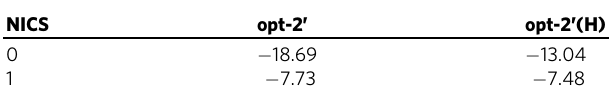
Table 3 Calculated NICS values (at point a , in ppm) of opt-2 ’ and opt-2 ’ (H) at the B3LYP/6-311G** level of